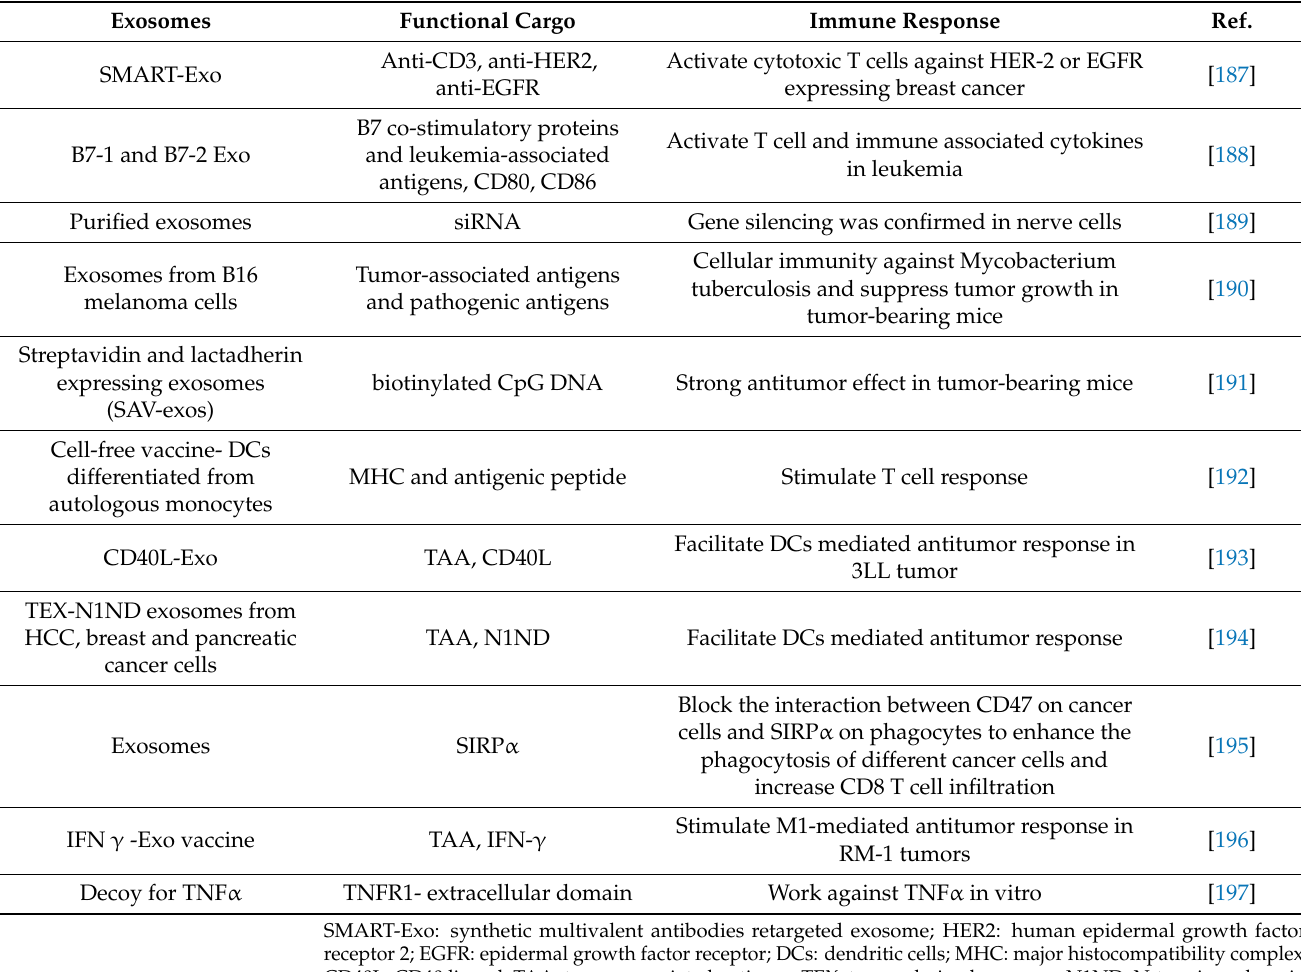
Table 2. Genetic engineering methods of exosomes in